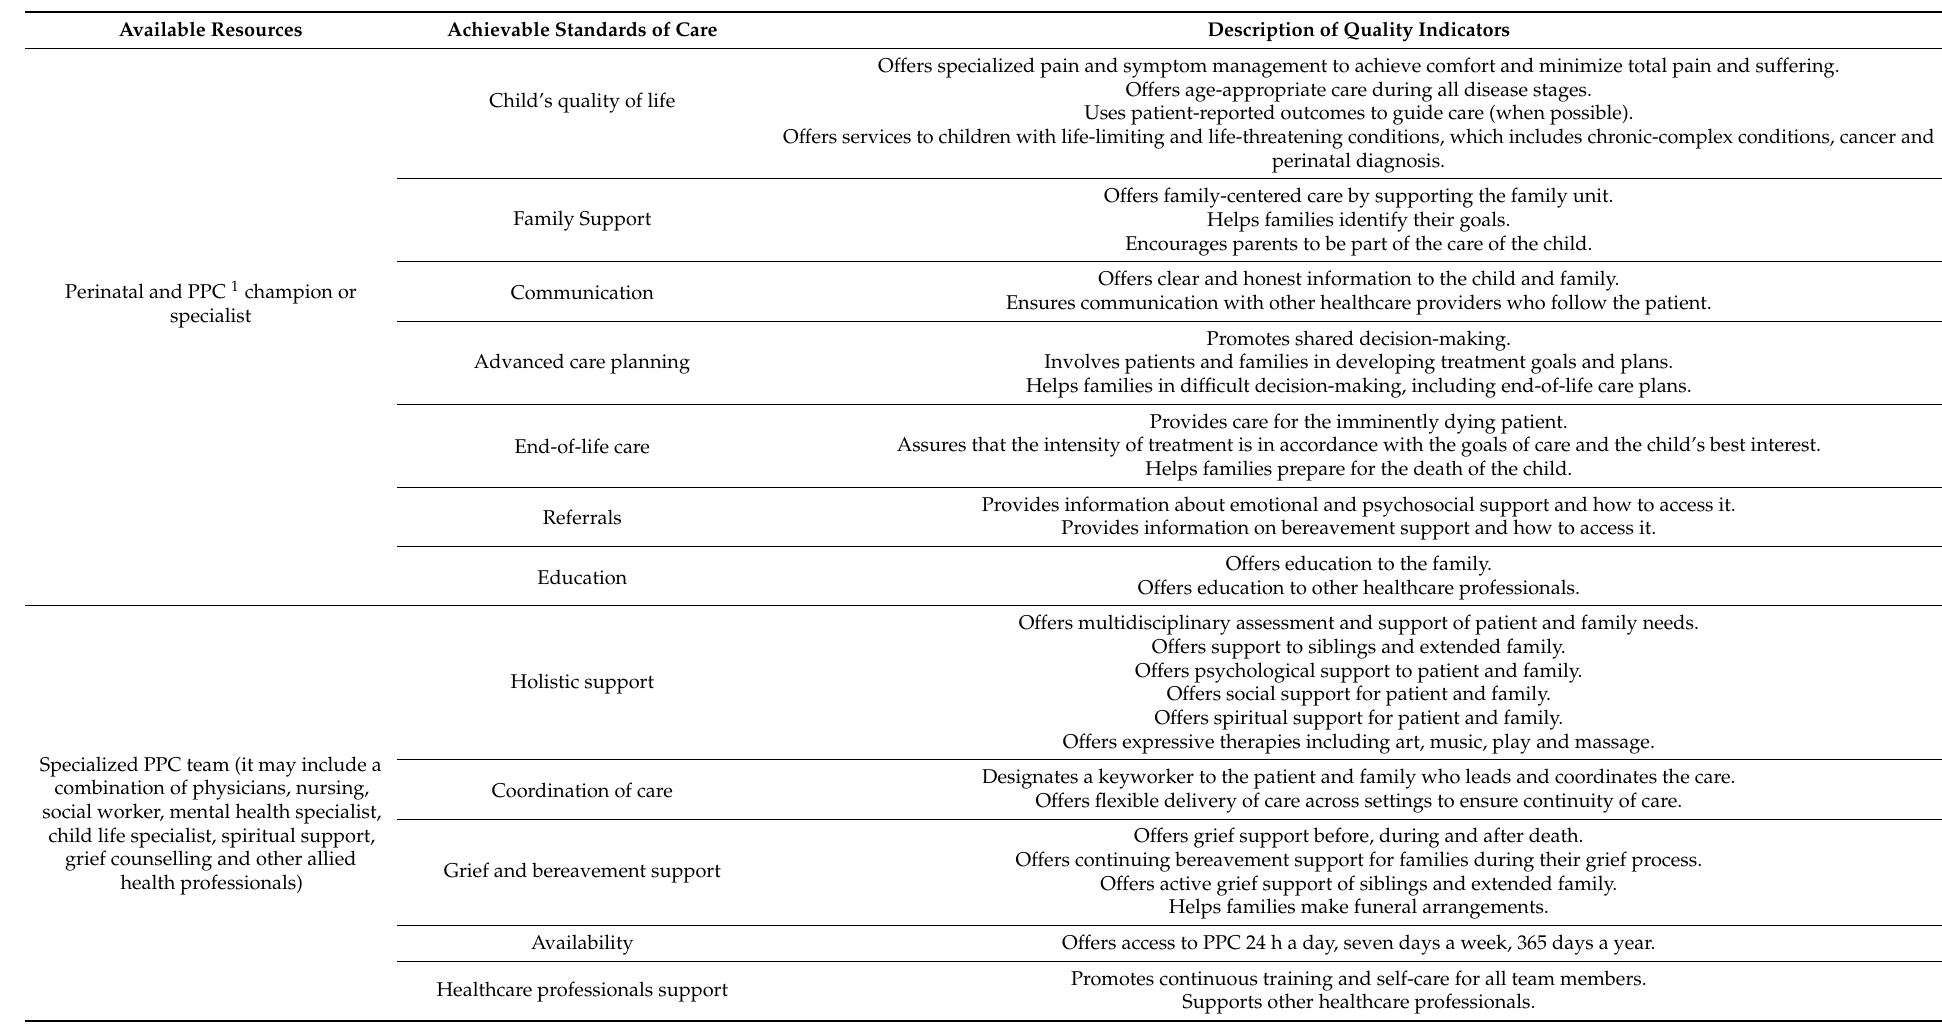
Table 1. Summary and categorization of standards of care and quality indicators based on the level of development of